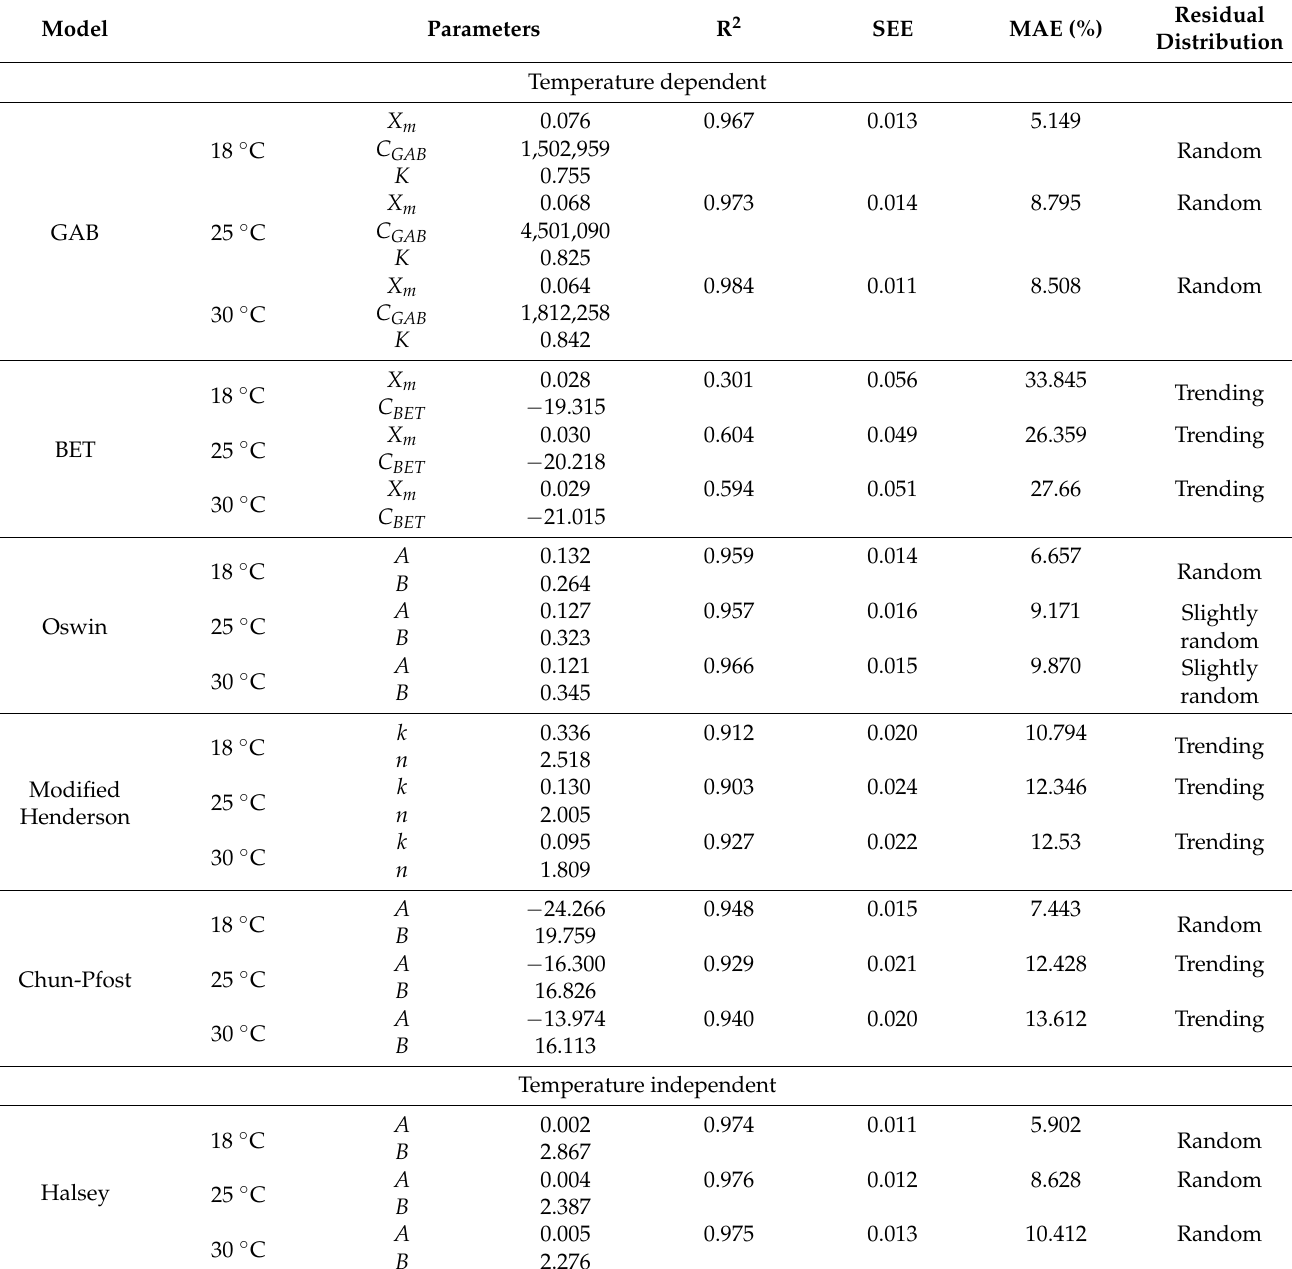
Table 3. Model parameters for adsorption